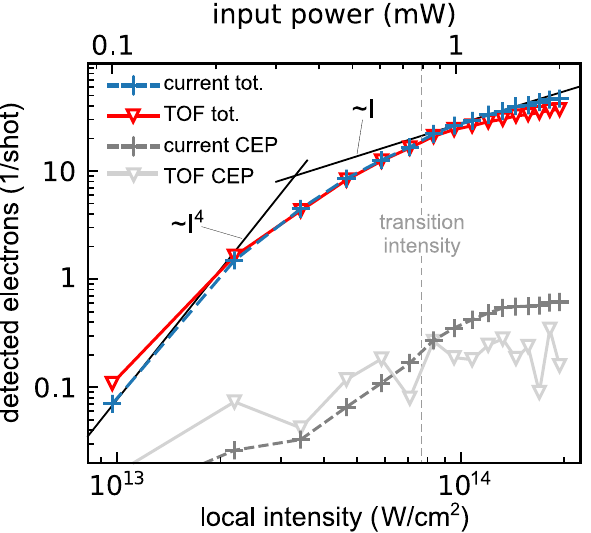
Figure 2: Evidence of charge interaction in the recorded electron yield and photocurrent measurement: CEP-averaged TOF (red) and current (dashed blue) count rate together with the detected CEP dependence (light gray and dark gray dashed, respectively). The latter indicates the amplitude of the change of each signal with CEP. The curves showing the current have been scaled by a factor of 1/70. The change in slope toward linear emission indicates substantial charge interaction, nevertheless, considerable CEP-control of the detected number of electrons is obtained. The black lines serve as a guide to the eye. The local intensity has been derived from the input power (top axis) via the calibration as described in the caption of Figure 3 and the main text. The vertical dashed line indicates the transition intensity of 7 . 5 × 10 13 W ∕ cm 2 .